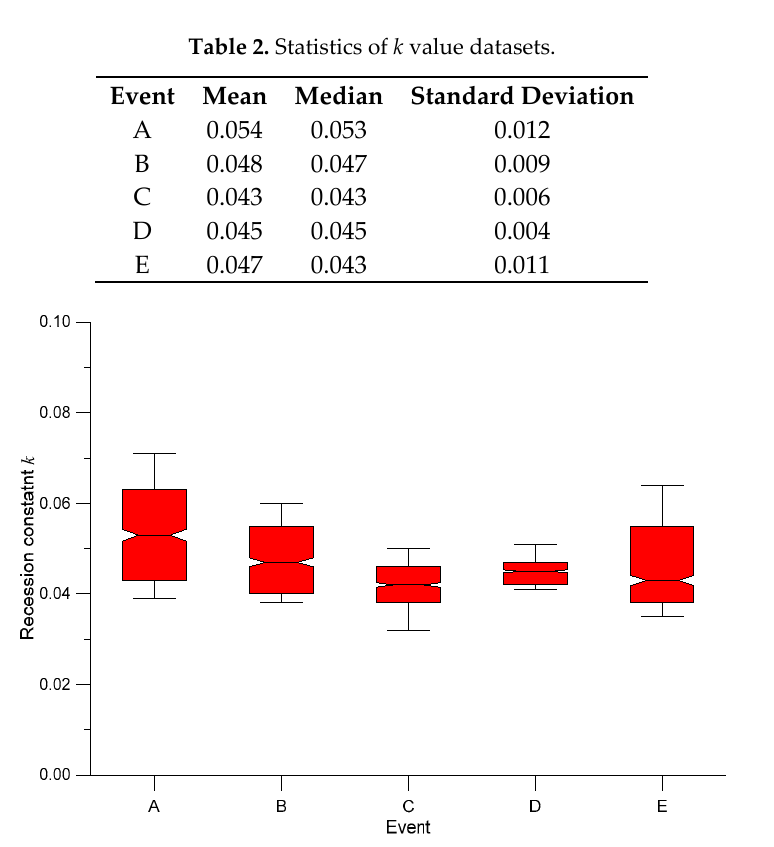
Figure 2. Boxplot of k values statistics for assessed events (whiskers at 10/90